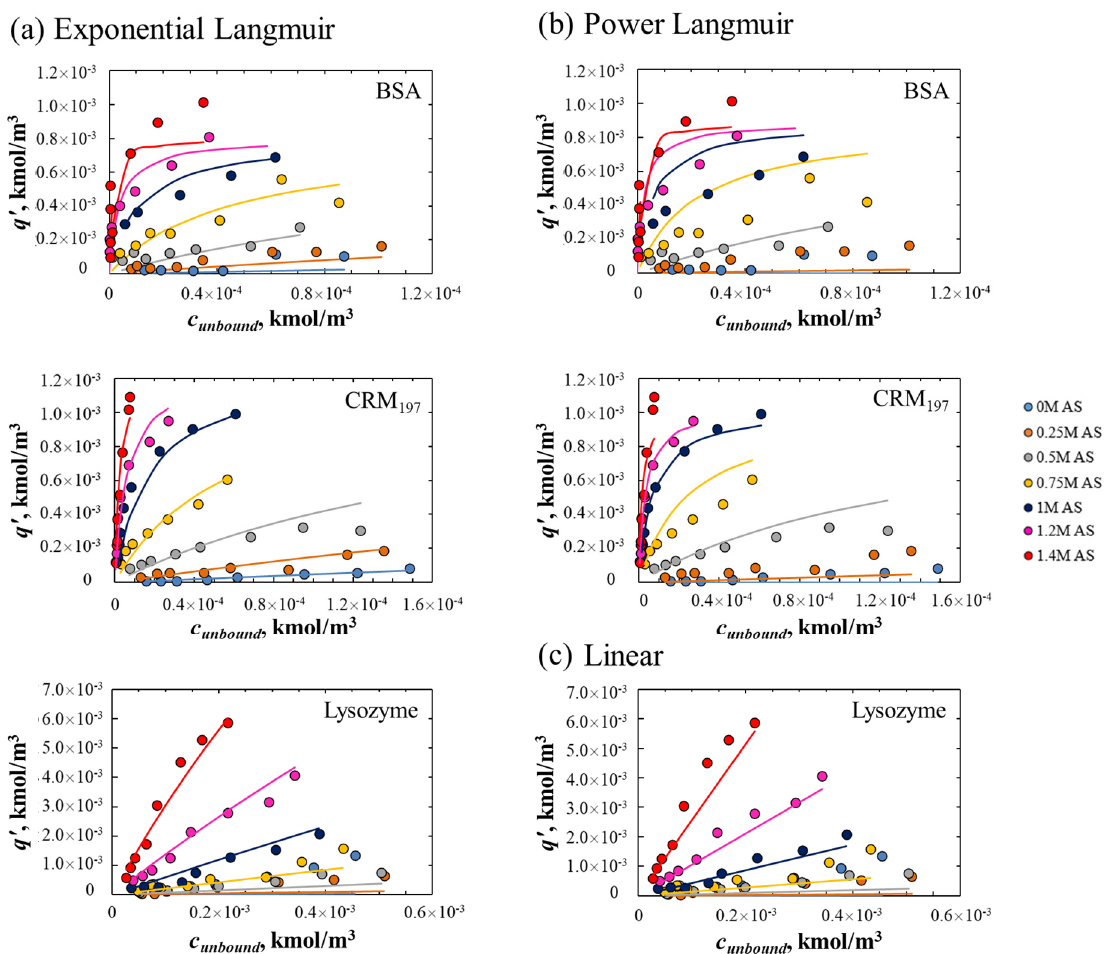
Figure 4. ( a ) Adsorption isotherms fitting with the exponentially modified Langmuir law. ( b ) Ad- sorption isotherms fitting with the power modified Langmuir law for BSA and CRM 197 . ( c ) Lyso- zyme adsorption isotherms fitting with the exponential linear